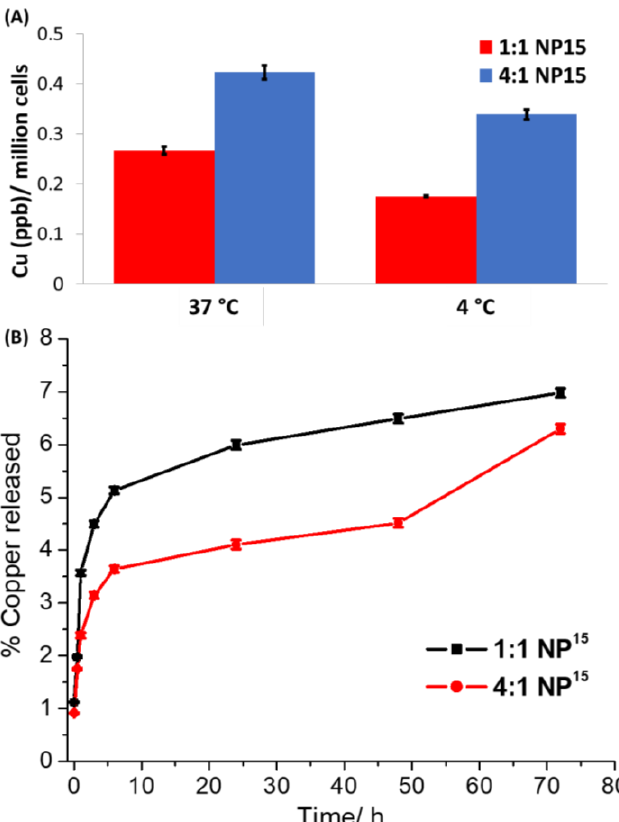
Figure 3. ( A ) Copper content in HMLER-shEcad cells treated with 1:1 NP 15 and 4:1 NP 15 (both 0.15 µM for 4 h) at 37 °C or 4 °C. ( B ) The amount of copper released from 1:1 NP 15 and 4:1 NP 15 upon incubation in PBS (pH 7.4) over the course of 72 h at 37 °C.